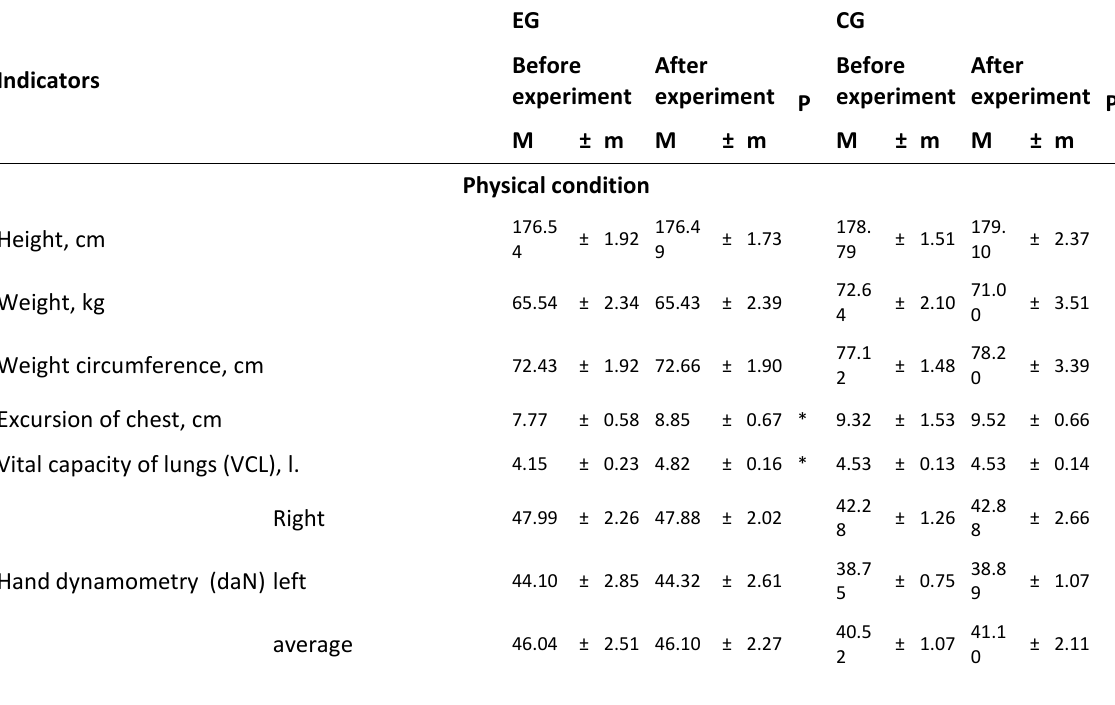
Table 2. Dynamic of students’ indicators in corrected variant of physical culture-health related technology for prophylaxis of respiratory system